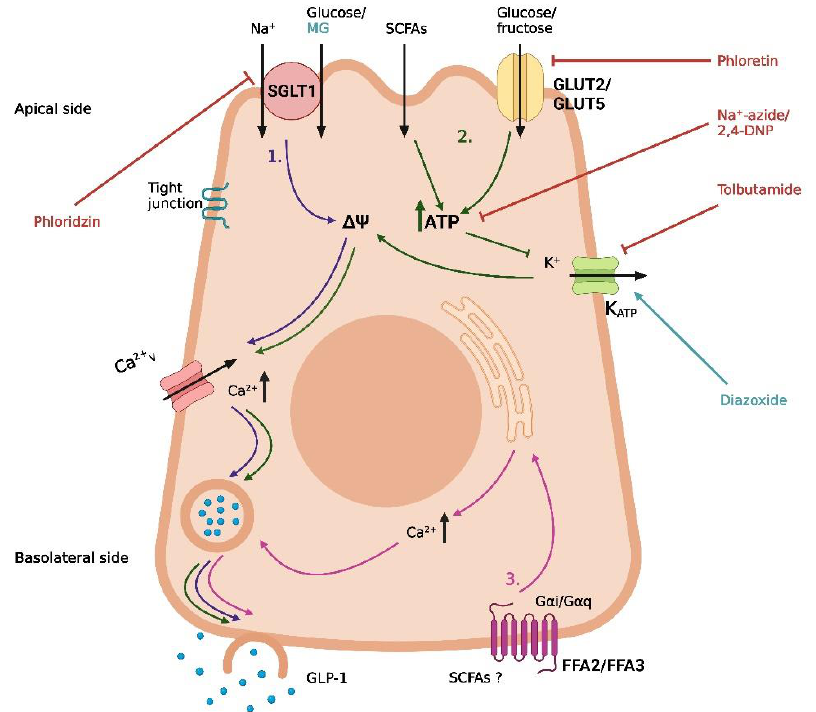
Figure 1. Proposed mechanisms of carbohydrate-induced GLP-1 secretion in intestinal L-cells. (1) Uptake of glucose/Na + by SGLT1, leading to depolarization and opening of voltage-gated Ca 2+ -channels. (2) GLUT2-mediated uptake of glucose, GLUT5-mediated uptake of fructose, and absorption of short-chain fatty acids (SCFAs), followed by intracellular metabolism, closure of K ATP channels, depolarization, and opening of voltage-gated Ca 2+ -channels. (3) Basolateral activation of FFA2 or FFA3 by SCFAs, leading to the release of intracellular deposits of Ca 2+ . Methyl-α-glucopyranoside (MG) is an agonist of SGLT1, phloridzin is an SGLT-1 inhibitor, phloretin is a GLUT2 inhibitor, Na + -azide and 2,4-DNP are metabolic inhibitors, tolbutamide is a K ATP channel inhibitor, and diazoxide is a K ATP channel opener. The graphic was created with BioRender.com.